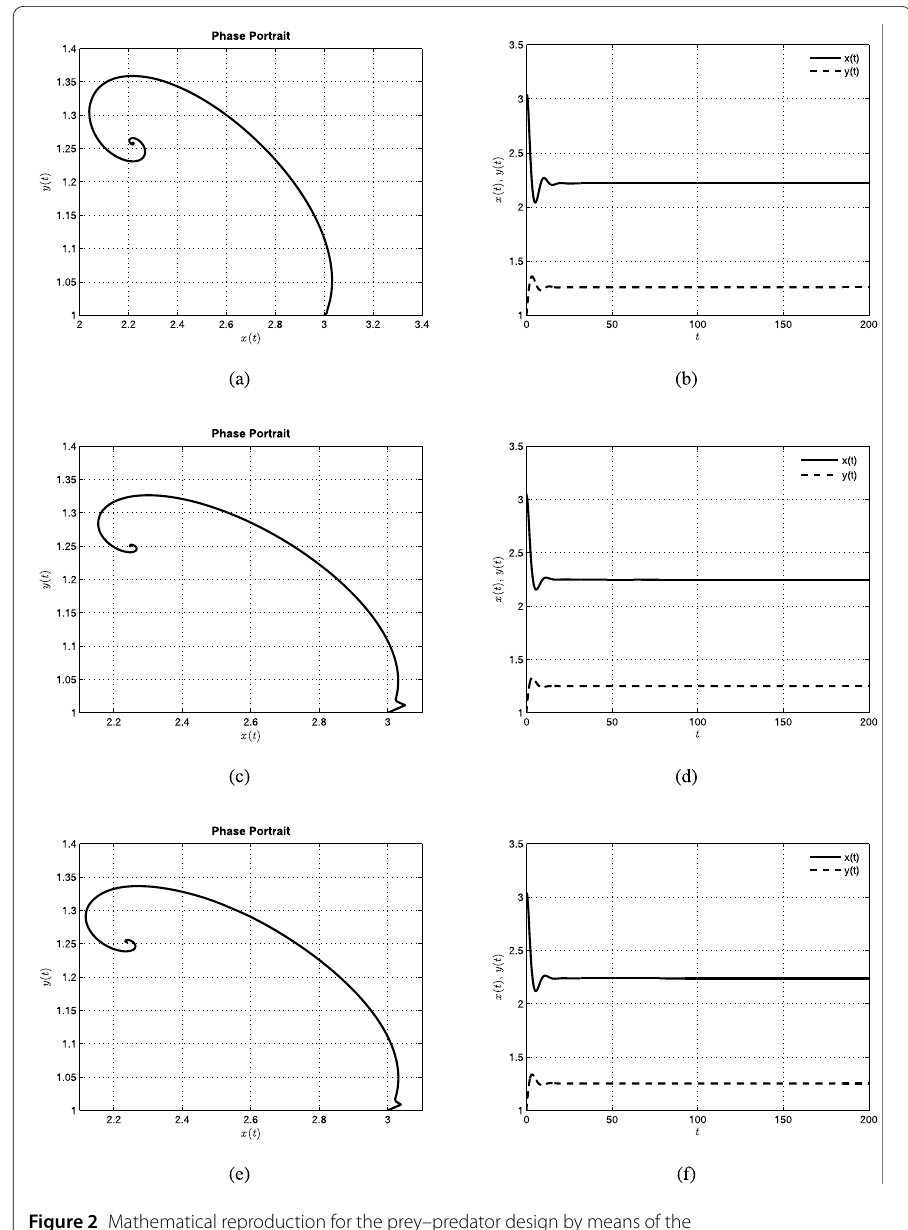
Figure 2 Mathematical reproduction for the prey–predator design by means of the Atangana–Baleanu–Caputo fractional derivative with variable order (2.7) through the numerical plan indicated by Eq. (3.26). In ( a )–( b ) phase portrait and time series x ( τ ) and y ( τ ) for (cid:2) = | sin( (cid:2)τ ) | and ς = tanh(3 – τ ). In ( c )–( d ) phase portrait and time series x ( τ ) and y ( τ ) for for (cid:2) = 1 – 1 In ( e )–( f ) phase portrait and time series x ( τ ) and y ( τ ) for (cid:2) = | sin( (cid:2)τ ) | and ς = 1 – 1